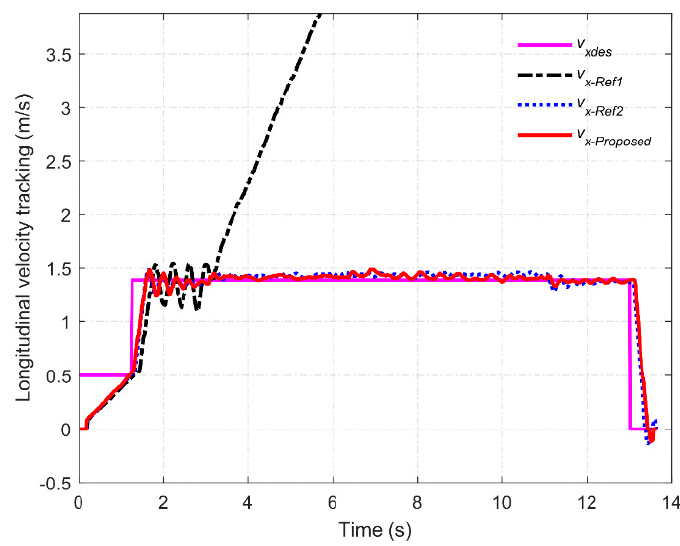
Figure 13. Longitudinal velocity tracking. Figure 13 compared the longitudinal velocity tracking. The longitudinal velocity of the UGV platform with the Ref1 controller diverged when the desired yaw rate was not zero. At 3 s, the desired yaw rate was set to 2.87 deg/s. Then, the Ref1 controller distributed the torque on each wheel to control the platform to track the desired longitudinal velocity and yaw rate.